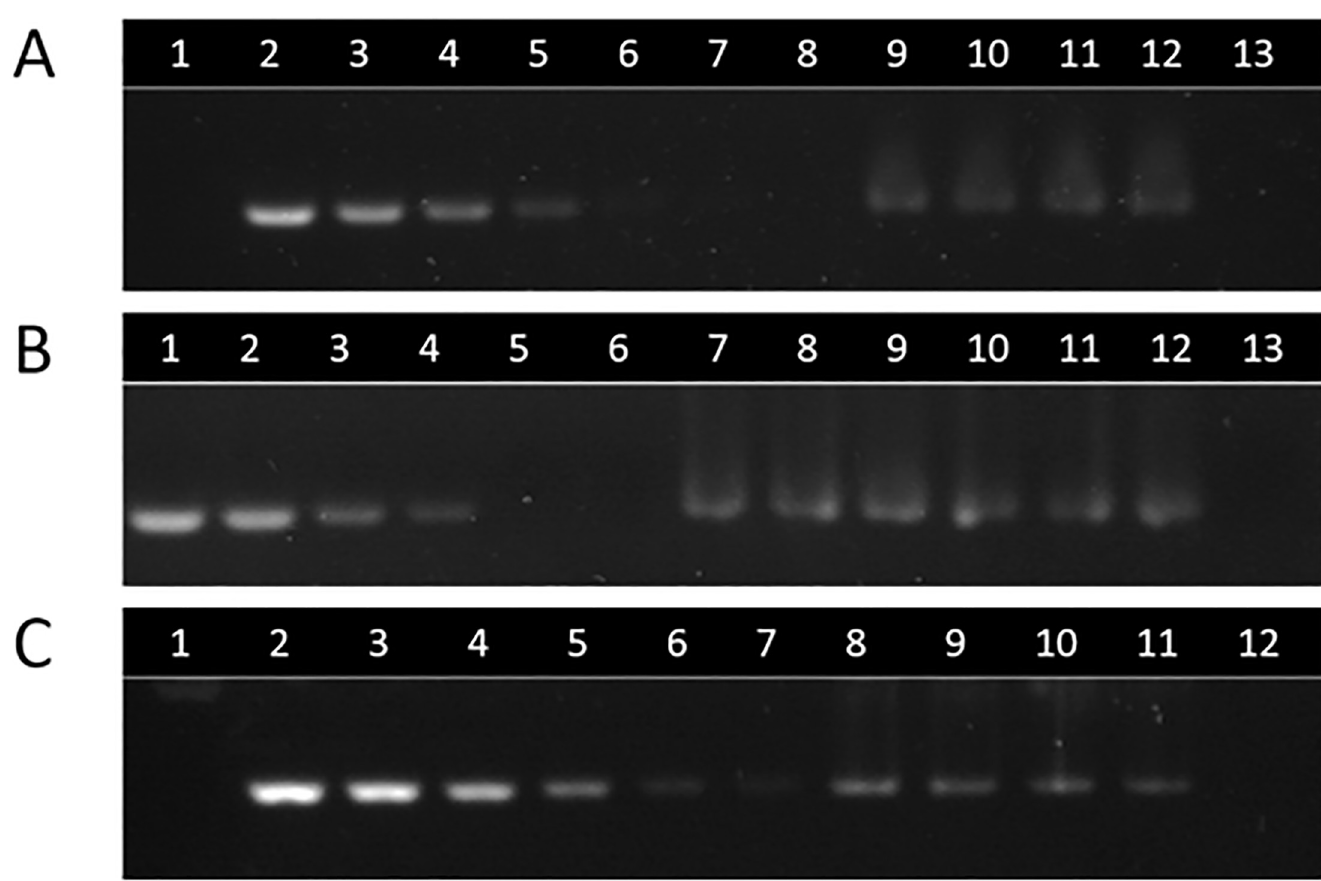
Fig 4. Agarose gel electrophoresis to quantify the TFD entrapped in chitosan nanocapsules. A) Addition of 50 μ g TFD. Lane 1, empty CS-NCs; lanes 2–7, free TFD calibration; lane 8, empty well; lanes 9–12, TFD-CS-NCs diluted 1:2; lane 13, filtered TFD-CS-NCs. B) Addition of 100 μ g TFD. Lanes 1–4, free TFD calibration; lanes 5–6, empty CS-NCs; lanes 7–9, TFD-CS-NCs diluted 1:5; lanes 10–12, TFD-CS-NCs diluted 1:10; lane 13, filtered TFD-CS-NCs. C) Addition of 200 μ g TFD. Lane 1, empty CS-NCs; lanes 2–7, free TFD calibration; lanes 8–11, TFD-CS-NCs diluted 1:8; lane 12, filtered TFD-CS-NCs.